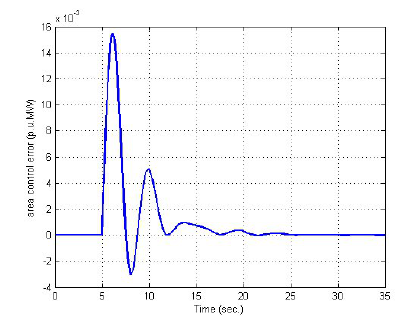
Fig. 6: ACE in control area 2 (Case 1)